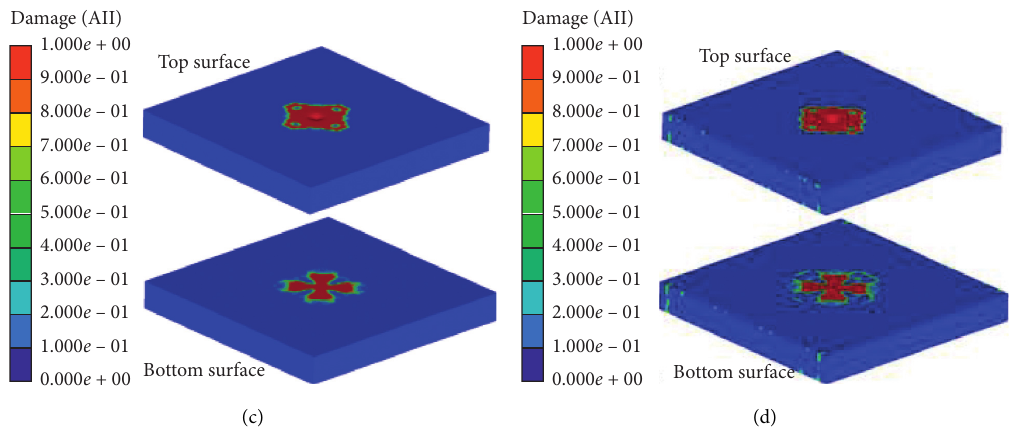
Figure 23: The damage processes of the RC slab under spherical explosive. (a) t � 0.01ms. (b) t � 0.02 ms. (c) t � 0.05ms. (d) t �